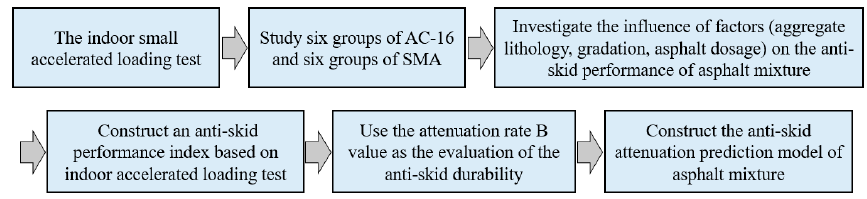
Figure 1. The flowchart.